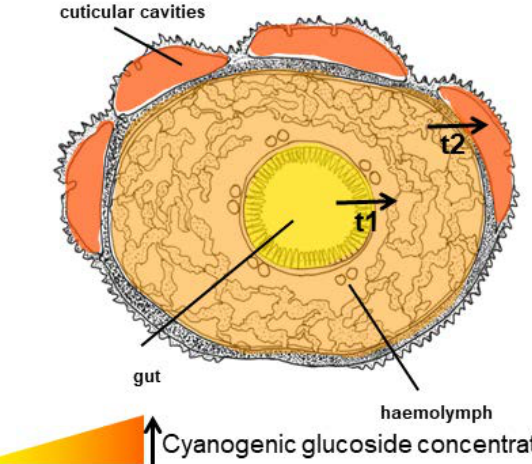
Figure 17. Cross-section of a Z. filipendulae larva showing the increasing concentration of CNglcs from the gut to the cuticular cavities, and the probable transport systems (t1 and t2).